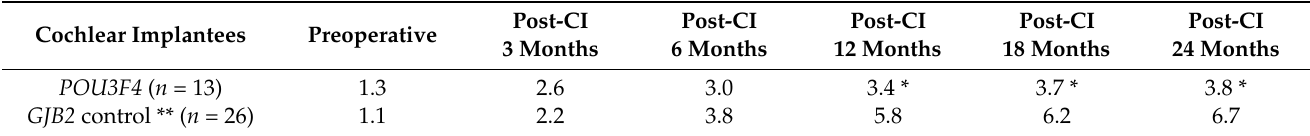
Table 3. Postoperative auditory perception score (CAP score) of cochlear implantees with POU3F4 variants